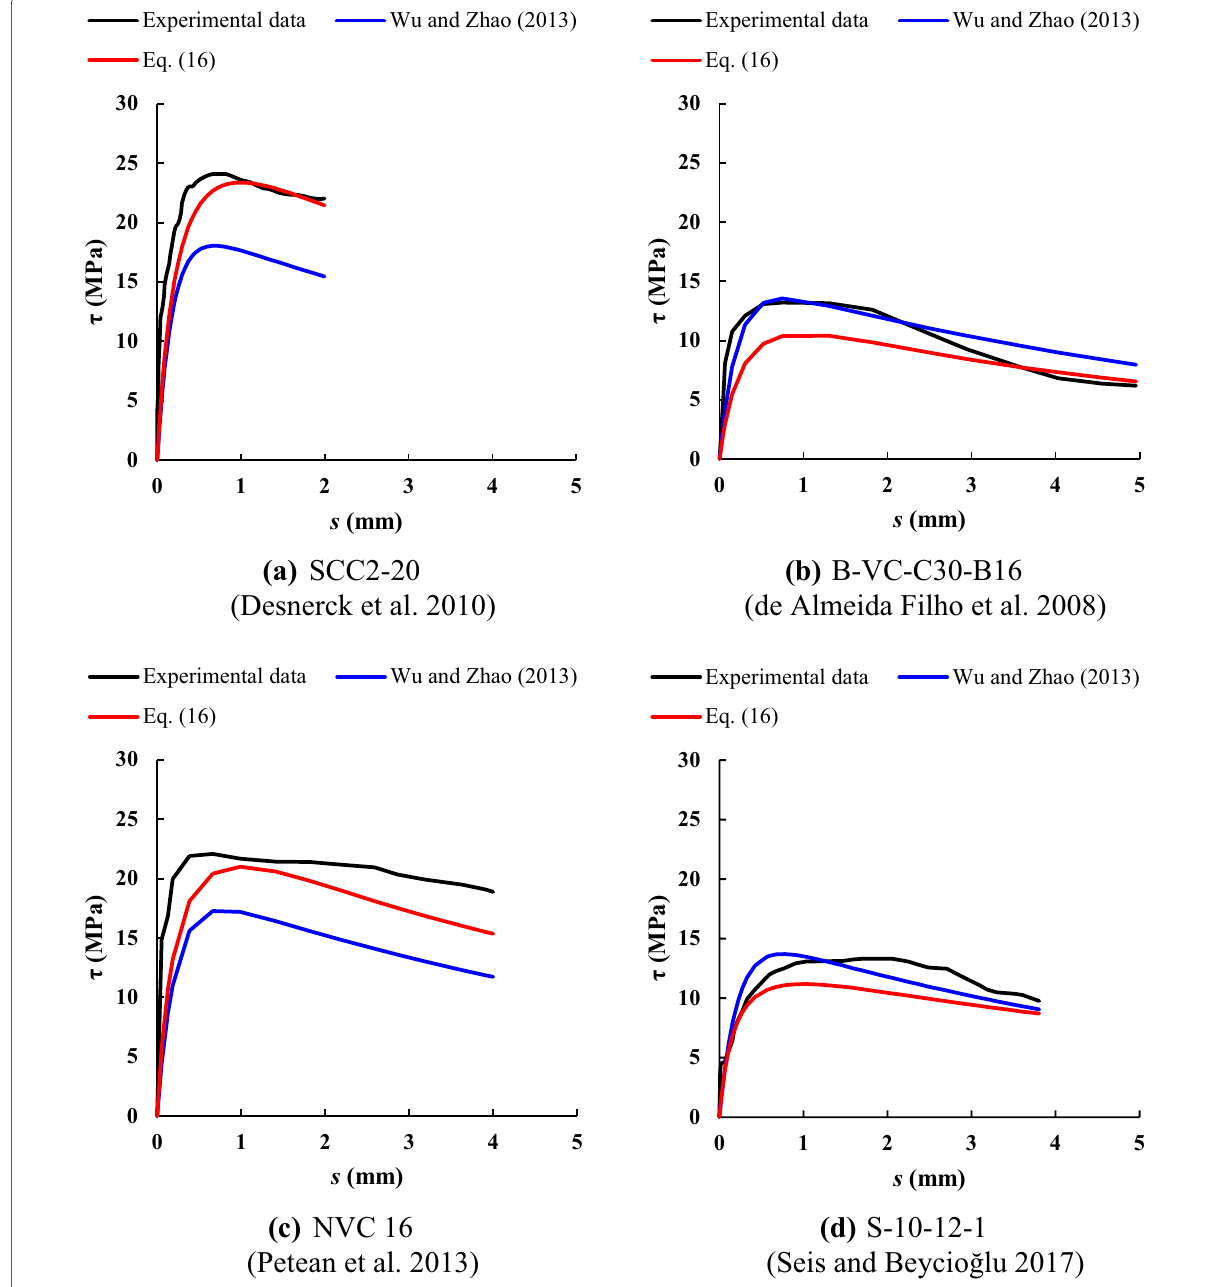
Fig. 13 Comparison of bond–slip